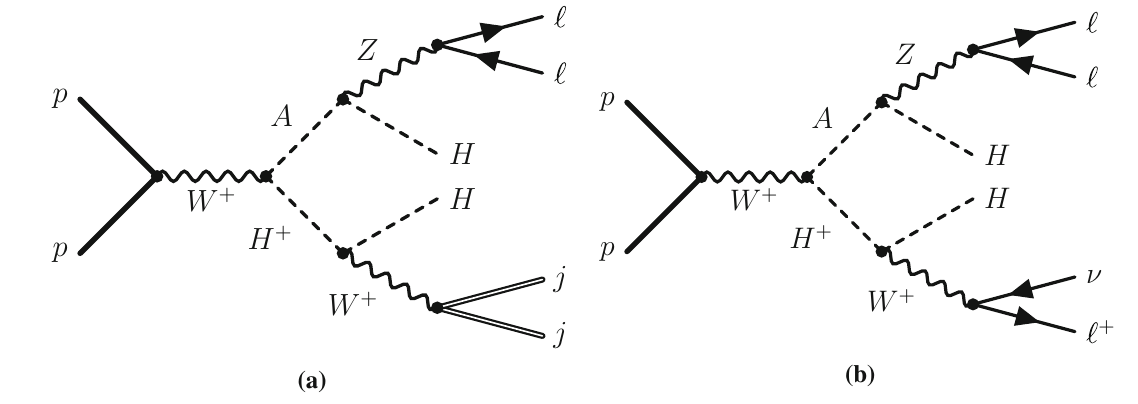
Fig. 3 The signal production chain in the di-lepton plus di-jet channel ( a ), and the tri-lepton channel ( b )